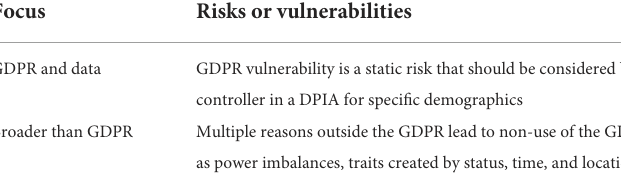
TABLE 1 Continuum from vulnerability to data